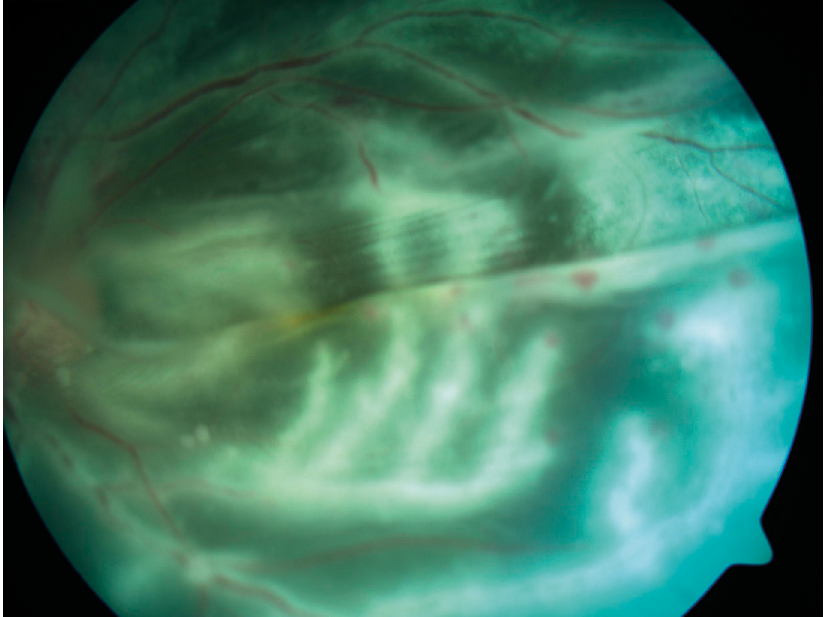
Fig. 2. Fundus photograph of the left eye of the same patient as in Fig. 1. Retinal detachment and